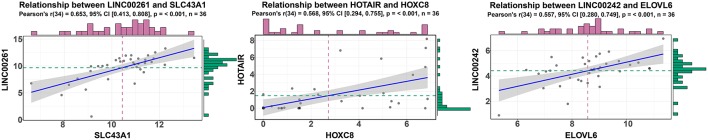
Regression analysis between the expression levels of DElncRNAs and DEmRNAs targeted by hsa-miR-211 in the ceRNA network (showing the top three correlation coefficients). The horizontal axis denotes the expression of the DEmRNAs, and the vertical axis represents the expression of the DElncRNAs. The upper and right edges are histograms of gene expressions.